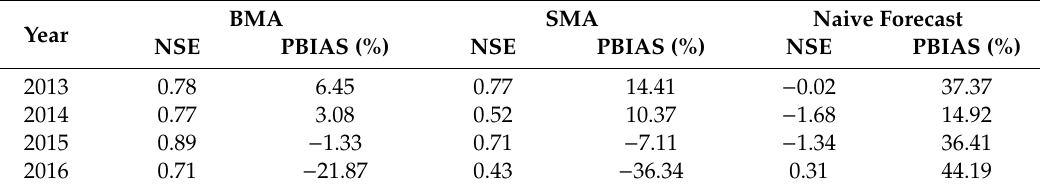
Table 6. Performance statistics for Bayesian model averaging (BMA), simple model averaging (SMA) and naive forecast